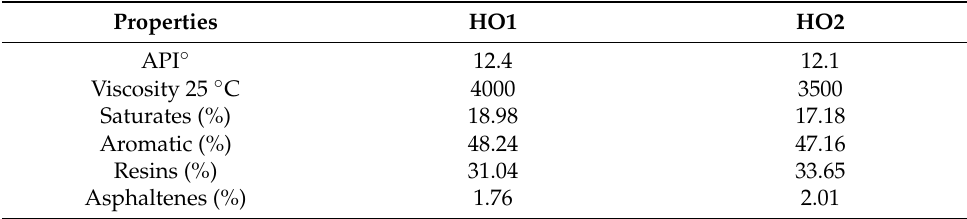
Table 4. Basic characteristics of heavy crude oil for the steam injection test.